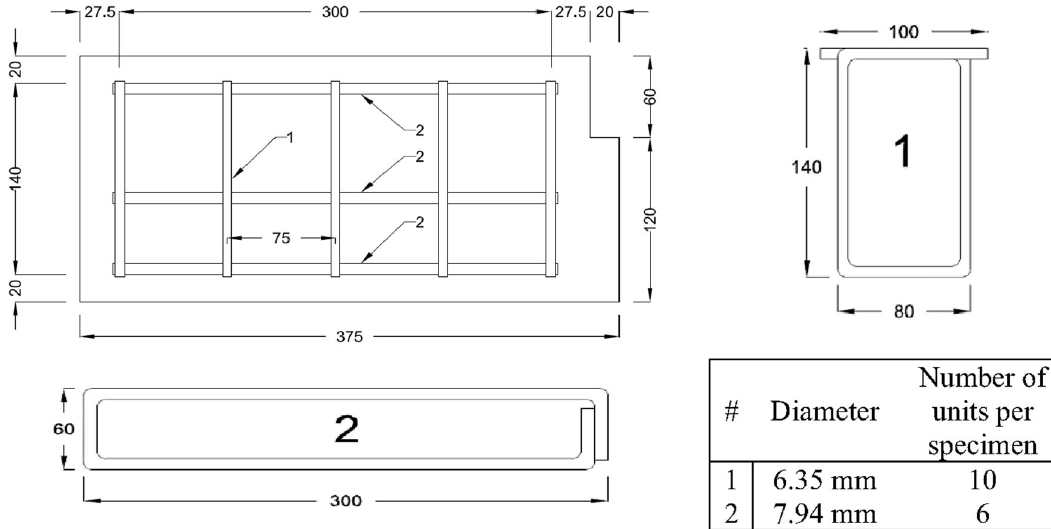
Fig. 2 Auxiliary reinforcement for Type A specimen (dimensions in mm).